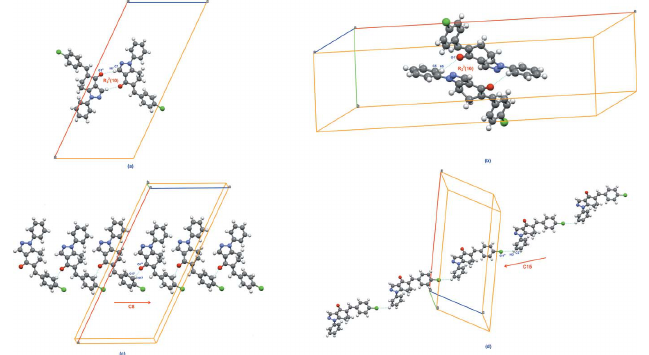
Figure 3 Views of significant C—H (cid:3)(cid:3)(cid:3) X interactions ( X = O or Cl) shown as